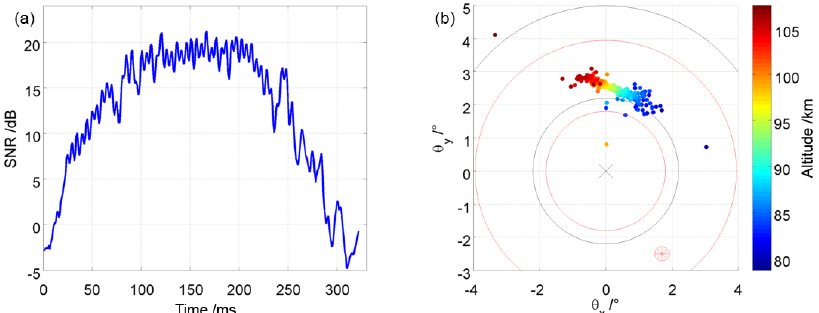
Figure 2. Example of a long lasting and intense meteor head echo observed with MAARSY on 18 January 2016 at 12:46UT. (a) Detected signal-to-noise ratio, (b) trajectory of the meteor in colour-coded altitude for zenith angles θ x and θ y . Black and red circles indicate the position of the first and second null and side lobes of the radiation pattern. The red asterisk mark an arbitrary position of a specular meteor